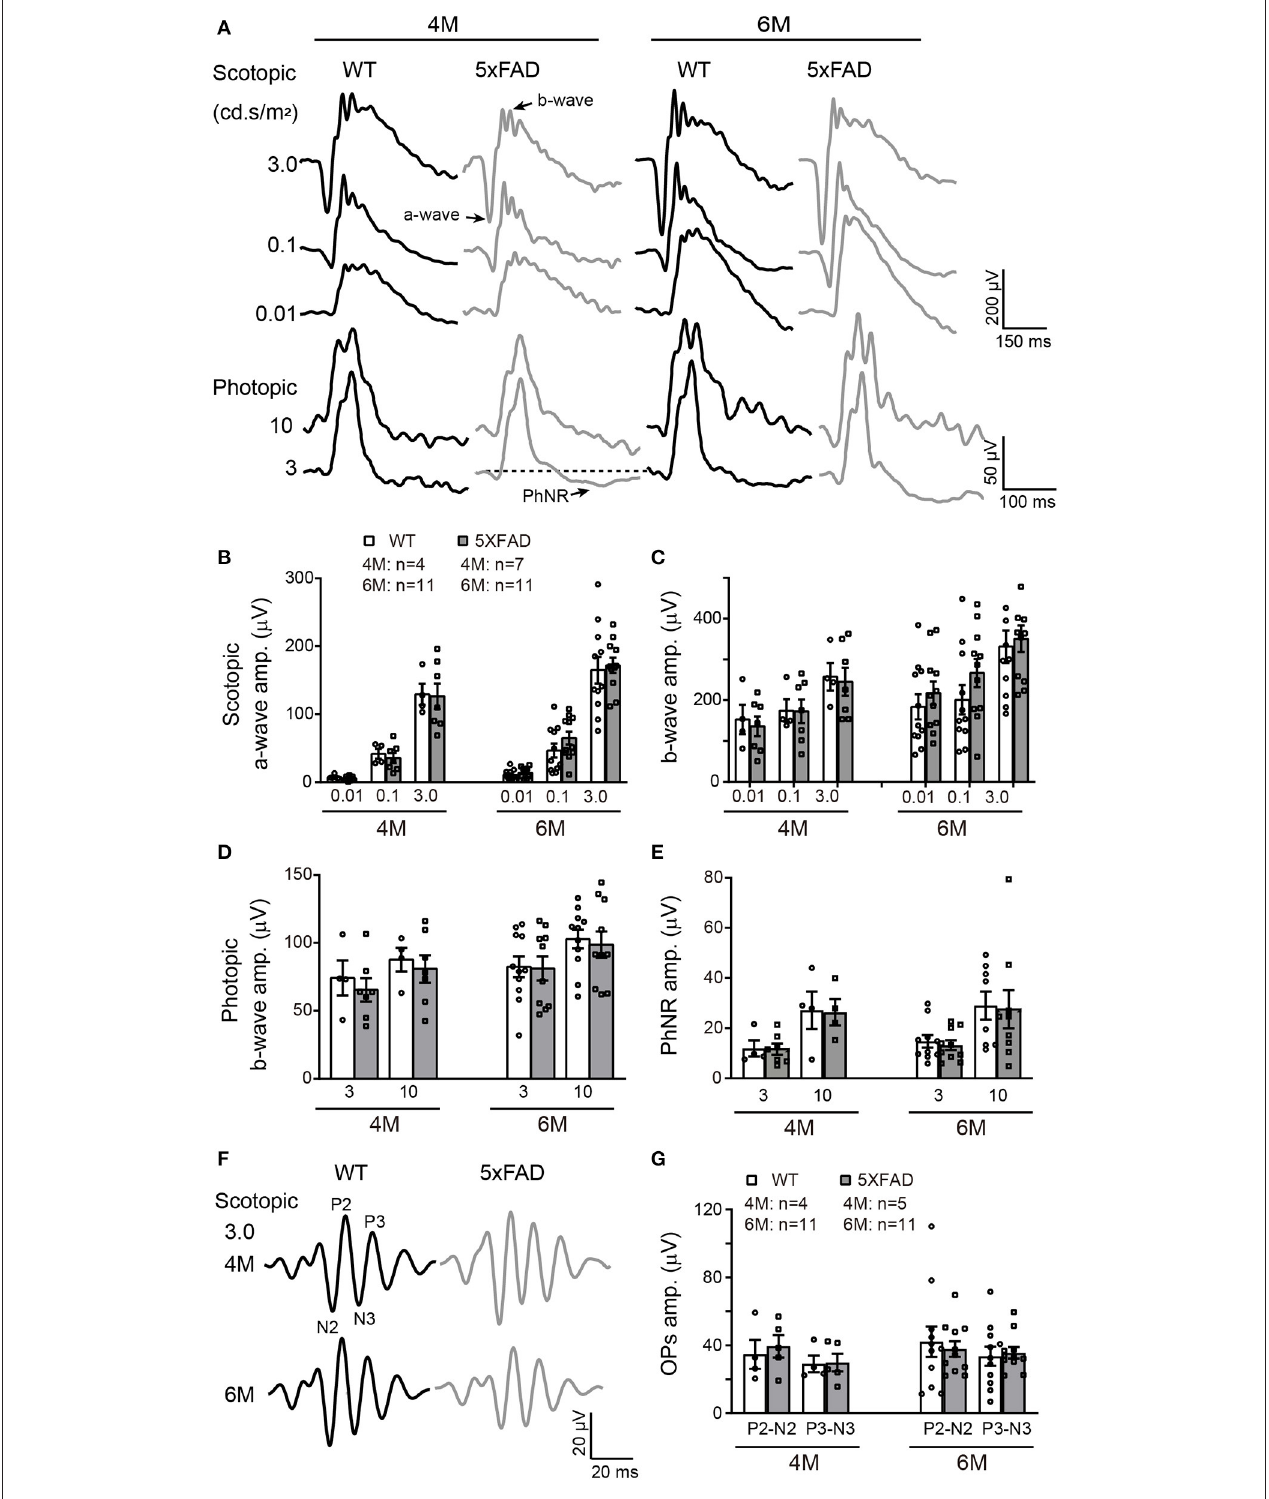
FIGURE 4 | The light responses of the first and second order retinal neurons are normal in 5xFAD. (A) Example ERG traces from a WT and 5xFAD mice at age of 4 and 6 months under dark adaptation (scotopic) and light adaptation (photopic). (B,C) Scattered plot of the amplitude of (B) a-wave and (C) b-wave under scotopic condition. (D,E) Scattered plots of the amplitude of (D) b-wave and (E) PhNR under photopic condition. (F) Example OPs traces to flash of 3.0cd s/m 2 under scotopic condition. (G) Scattered plots of the amplitude of P2-N2 and P3-N3. Data shown as mean ± SEM.